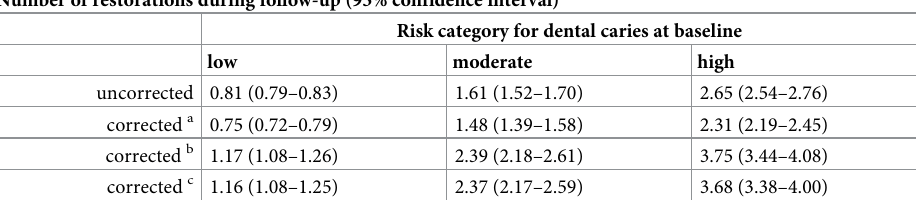
Table 4. The uncorrected and corrected number of restorations during follow-up per baseline risk category for dental